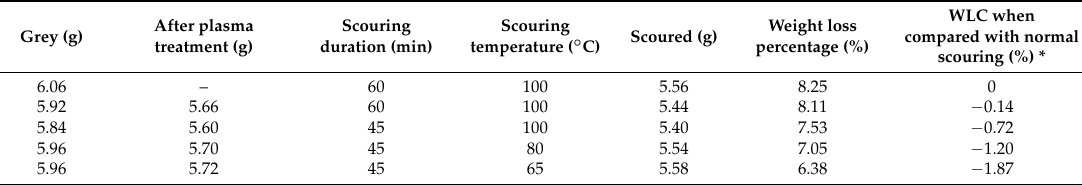
Table 5. Weight-loss difference (WLC) between plasma-treated and scoured single jersey fabric (plasma condition: 150 W output power and 0.4 L/min flow rate).